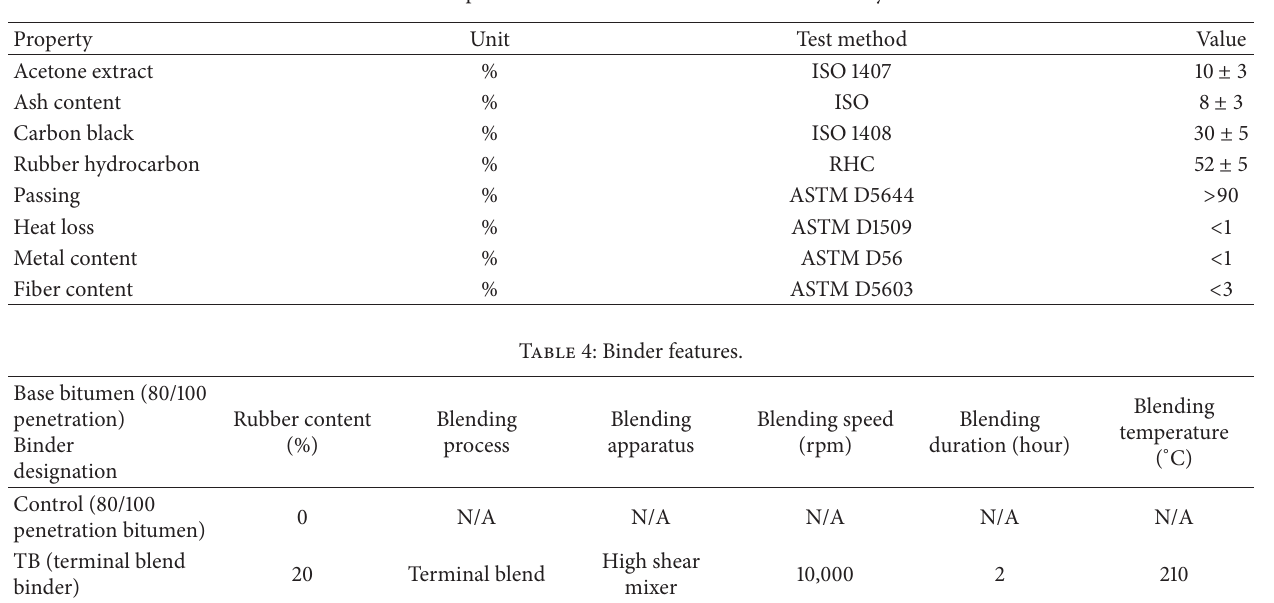
Table 3: Specification of crumb rubber used in this study.